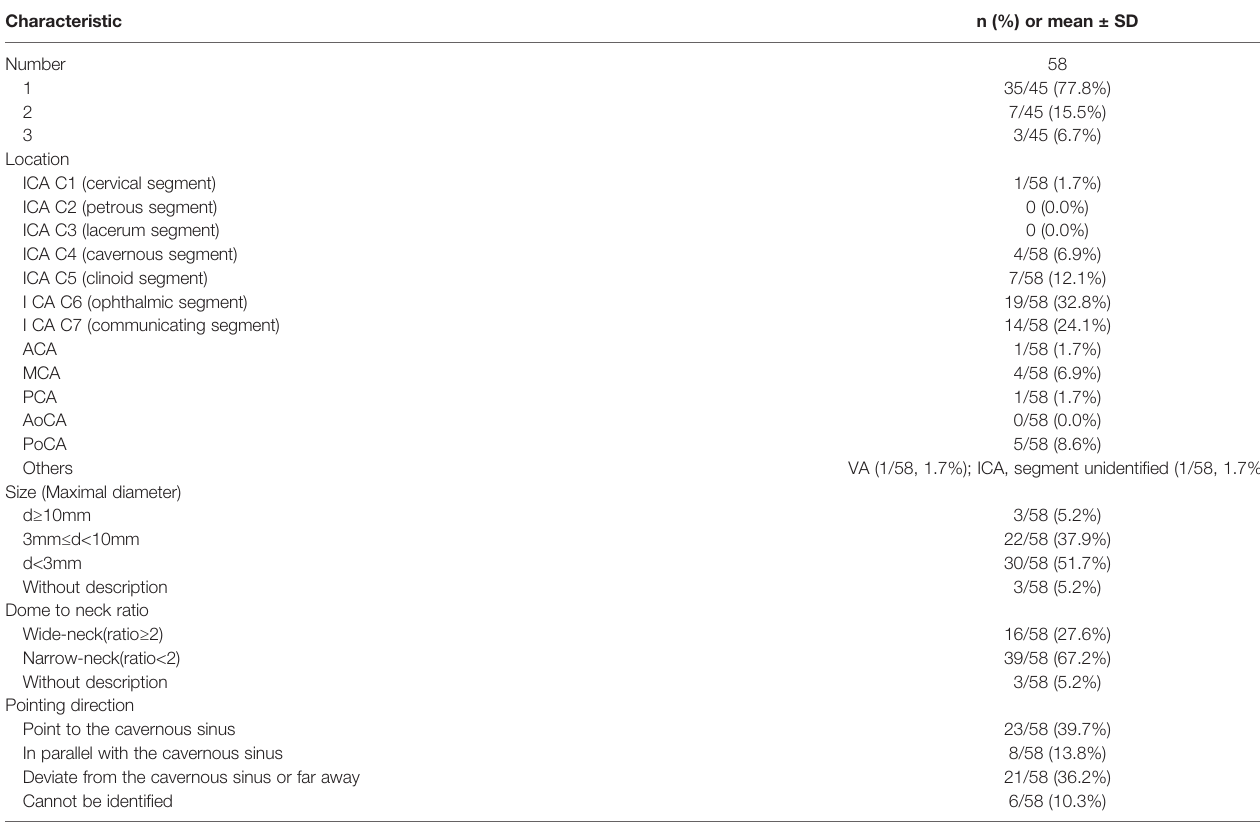
TABLE 3 | Clinical characteristics and radiological pro fi les of IAs. Characteristic